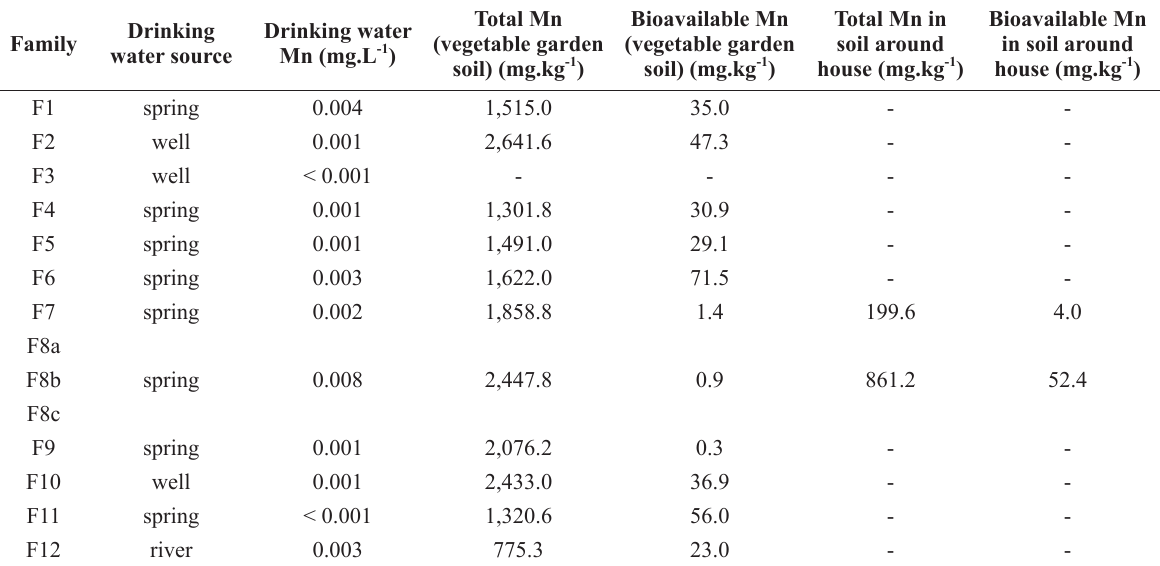
Mn content in drinking water and soil samples taken from selected families’ places.